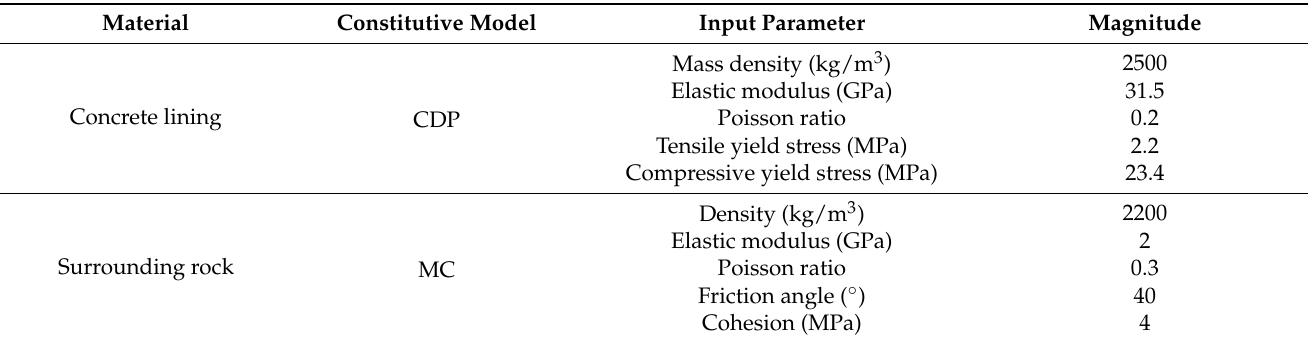
Figure 4. Schematic diagram of lining ring. Table 2. Material parameters of surrounding rock and concrete lining.